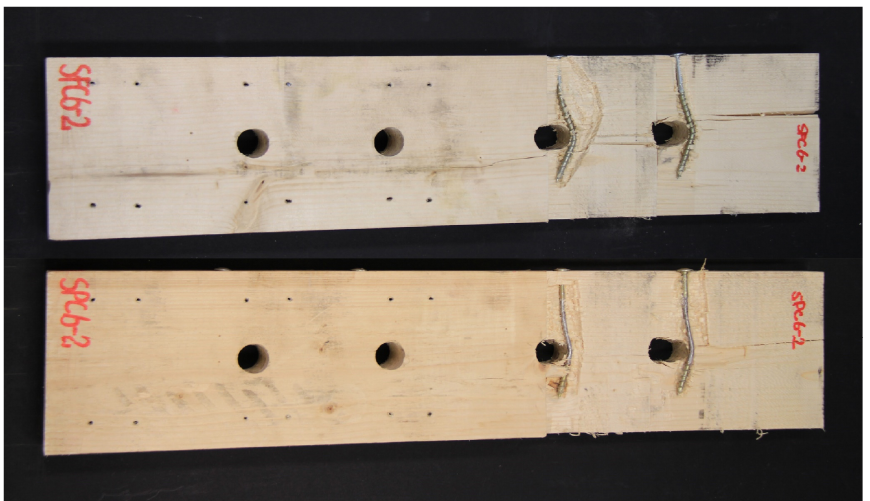
Figure 11. Timber members of connection specimens after failure showing deformation of screws. Top: connections reinforced by screws with complete thread (SFC). Bottom: connections reinforced by screws with 33% thread on the point end (SPC) [31].